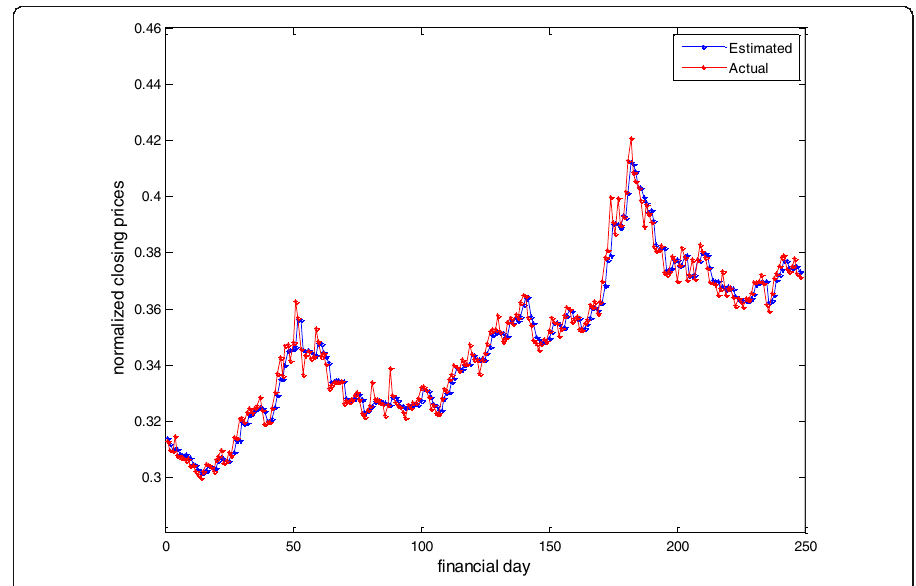
Fig. 9 Actual v/s estimated closing prices by CPNN-GA for FTSE